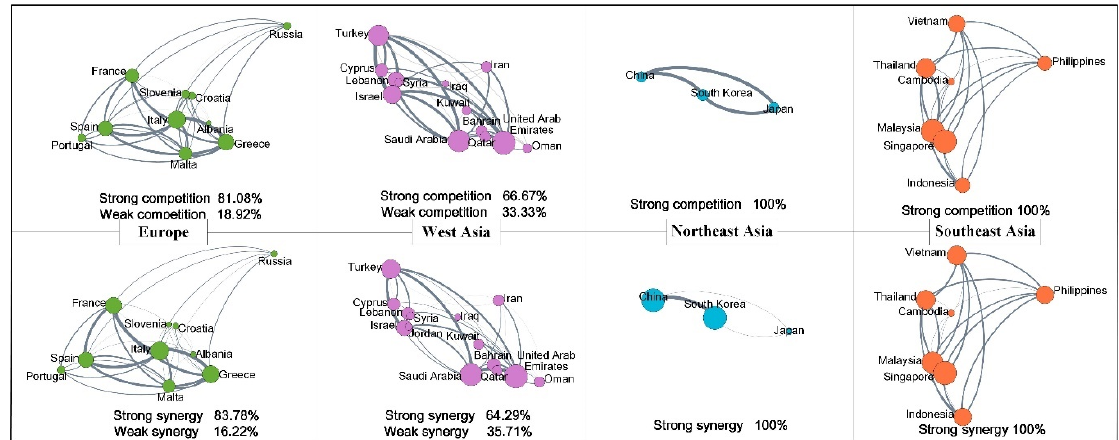
Figure 12. Significant traffic network between regional countries. The visualization is made by Gephi. The thicker the connecting line, the stronger the relation between the two countries.